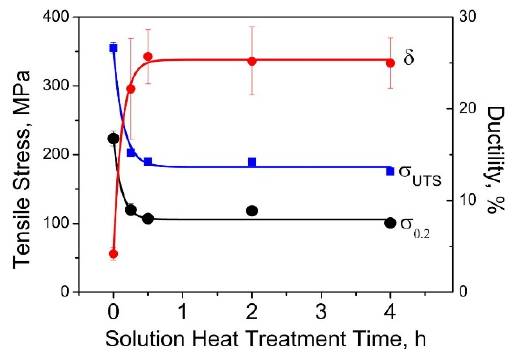
Figure 59. Variation in the mechanical properties of the Al-12Si alloy upon solution heat treatment for different durations. δ , σ 0.2 and σ UTS represent the ductility, yield strength and ultimate tensile strength, respectively [130]. Copyright 2015. Adapted with permission from Elsevier Science Ltd.